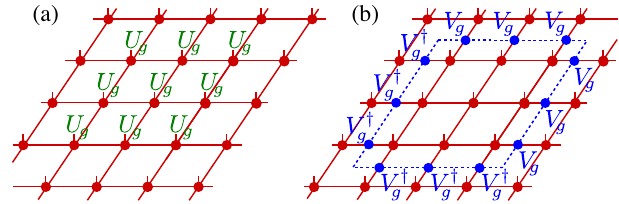
FIG. 14. Disorder parameter constructed from a physical symmetry action on a membrane (a) and its reformulation in terms of an entanglement symmetry (b); see the text for